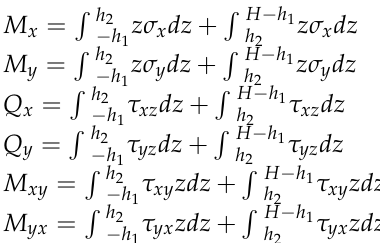
σ , are linearly distributed along the The stress components x thickness direction and correspond to zero on the neutral layer. The normal stress the thickness direction can be calculated from the equilibrium differential equation of the elasticity theory [23]. The internal force is obtained with Equation (2):